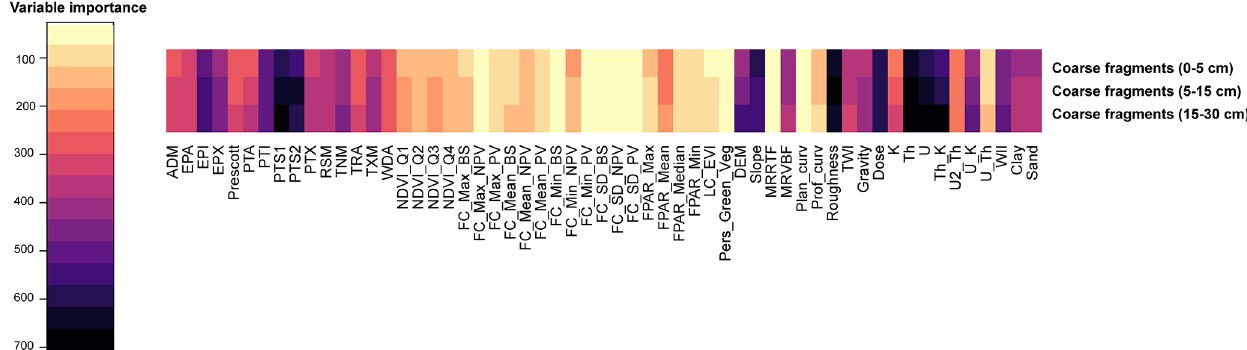
Figure 6. Variable importance of random forest probability models for coarse-fragment classes. Variable importance was estimated with Gini index impurity (Sandri and Zuccolotto, 2008).